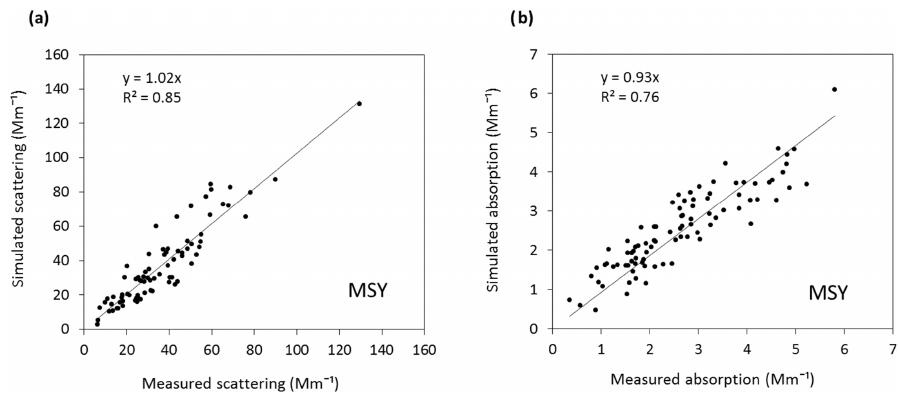
Figure 6. Relationship between modelled and measured (a) scattering at 525nm and (b) absorption at 637nm at MSY for the period January 2015–December 2015. Table 3. Theil-Sen (TS) trends at a 95% confidence level for deseasonalized monthly averages of scattering absorption time series at MSY during the period 2004–2014. AR (Mm − 1 ; %) is average reduction; TR (%) is total reduction; the significance of the trends ( p value trend) was obtained by means of TS method using monthly averages: ∗∗∗ ( p value<0.001), ∗∗ ( p value<0.01), ∗ ( p value<0.05). The non-linearity parameter (%) was calculated by means of the multi-exponential (ME) test.